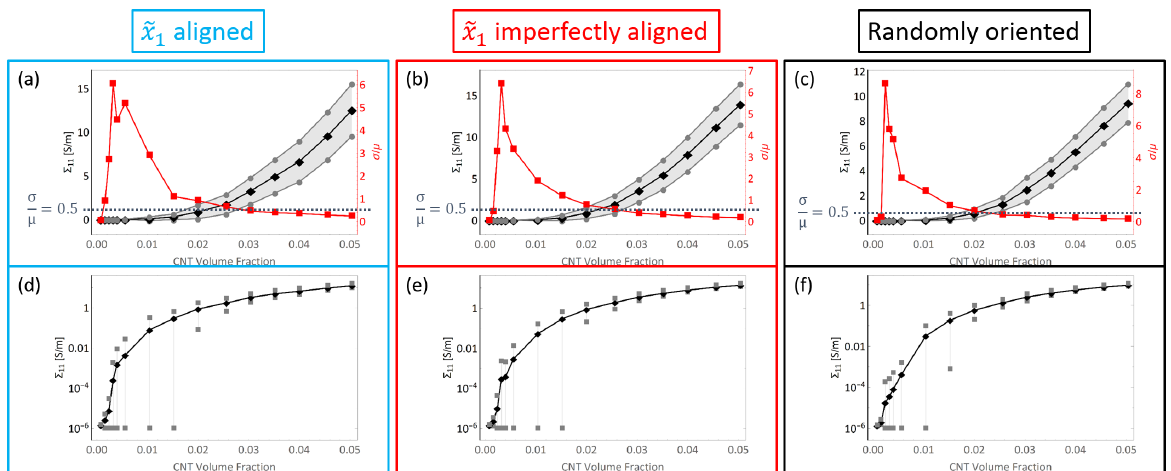
Figure 13. The mean, mean ± standard deviation and coefficient of variation are depicted in black, grey and red, respectively, for Σ 11 for ( a ) straight ˜ x 1 aligned CNTs, ( b ) straight ˜ x 1 imperfectly aligned ( ± 15 ◦ ) CNTs and ( c ) straight randomly oriented cases, respectively. The mean and mean ± standard deviation are depicted in black and grey, respectively, for Σ 11 in semi-log plots for ( d ) straight ˜ x 1 aligned, ( e ) straight ˜ x 1 imperfectly aligned and ( f ) straight randomly oriented cases, respectively.